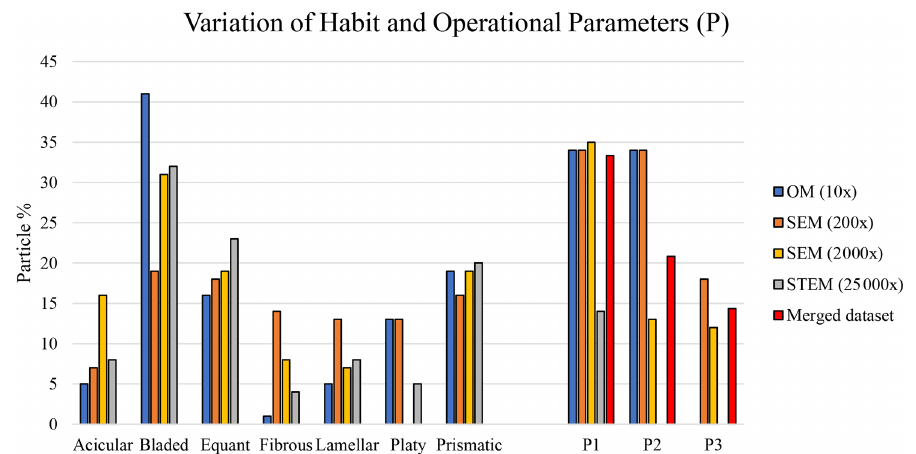
Figure 16. Habit variation using different types of microscopy and magnification. Habit nomenclature after Zoltai (1981), and Veblen and Wylie (1993). The variation of the different operational parameters is shown as P1, P2, and P3, where P1 represents L/w ≥ 3 only (Gunter, 2018; including the nano-sized portion of the mineral particle population), P2 shows L/w ≥ 3 and L> 5 (i.e., EMP according to the National